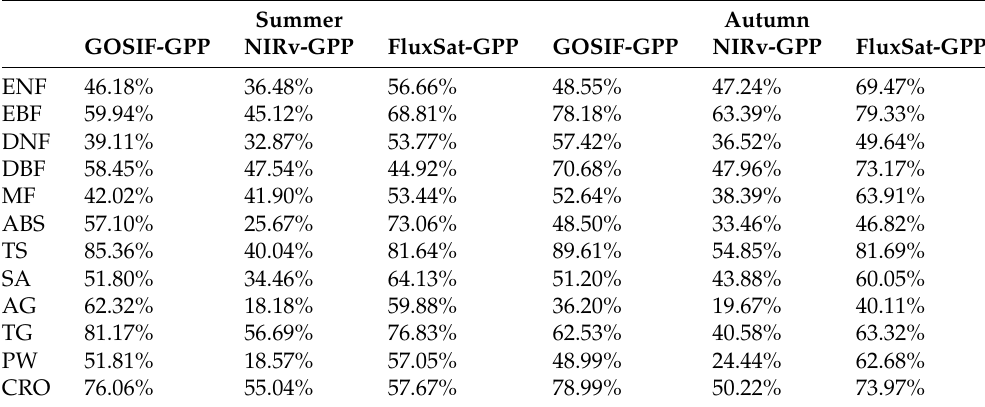
Figure 7. Relative importance (%) of environmental and biological drivers on GPP summer ( a – c ) and GPP autumn ( d – f ) based on different biomes. Table 4. Percentage of pixels with significant correlations, as seen in Figure 7 divided by biome-type and season. The first three columns correspond to summer, and the following to